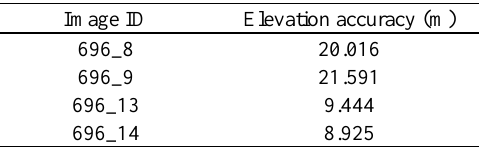
Table 2. Elevation accuracy of SAR images before